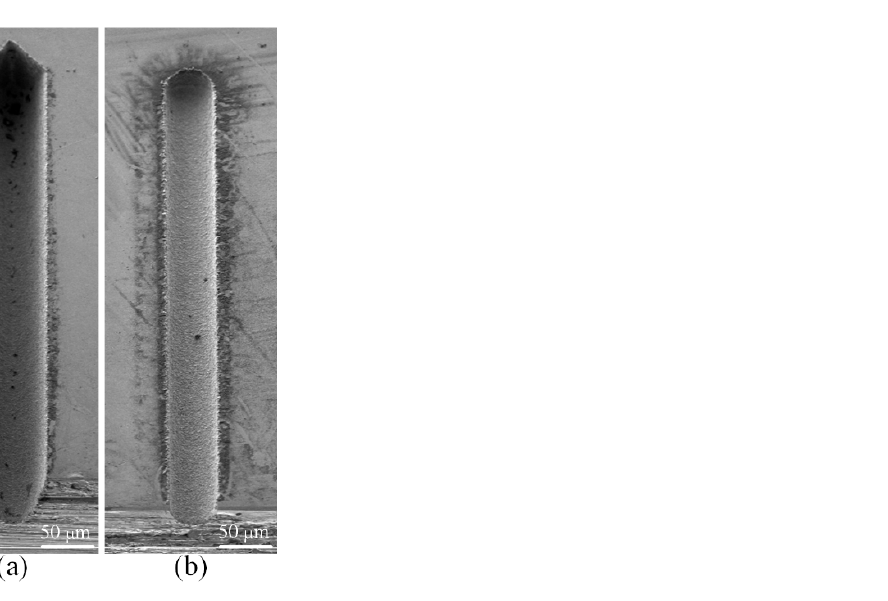
Figure 21. SEM images of the two microgrooves in Exp. 3: ( a ) square electrode-rotate 45° in advance-nonrotating mode; ( b ) cylindrical electrode-nonrotating mode.